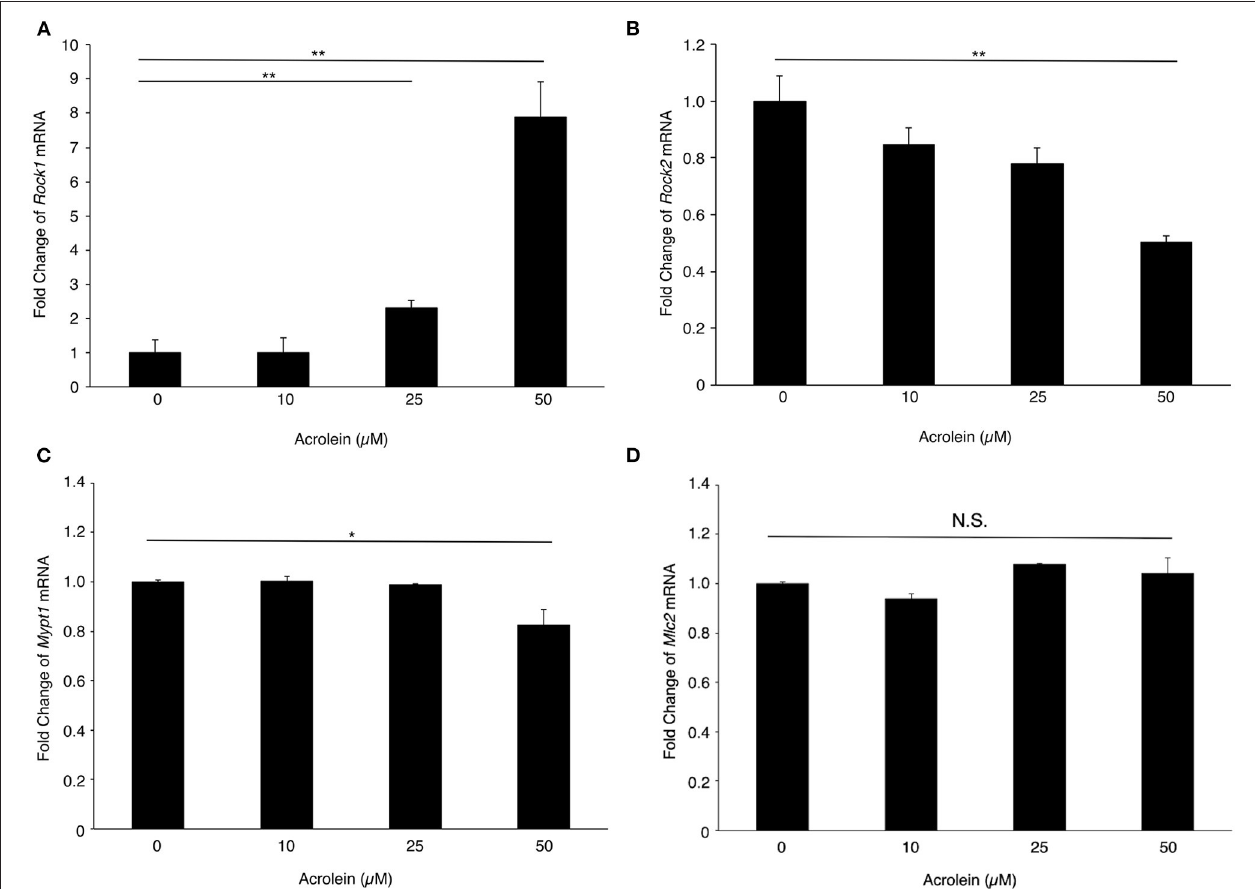
FIGURE 2 | Effect of acrolein on transcriptional levels of Rocks , Mypt1 , and Mlc2 in TR-MUL5 cells. The mRNA expression levels of (A) Rock1 , (B) Rock2 , (C) Mypt1 , and (D) Mlc2 when TR-MUL5 cells were incubated with acrolein (0–50 µ M, n = 6 each). Values represent mean ± SEM; * P < 0.05; ** P < 0.01; N.S., not significant.